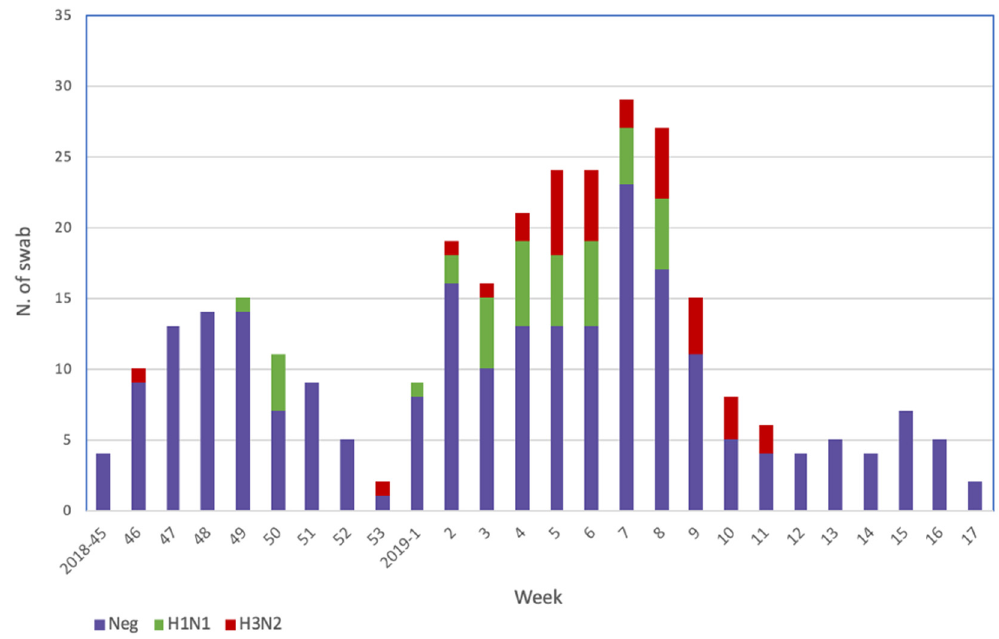
Figure 1. Weekly distribution of samples collected and influenza virus types/subtypes detected.